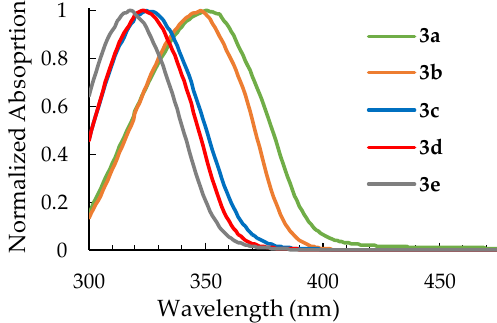
Figure 1. Normalized absorption spectra of compounds 3a – e in ethanol: 3a λ max = 357 nm; 3b λ max = 354 nm; 3c λ max = 332 nm; 3d λ max = 323 nm; 3e λ max = 314 nm.